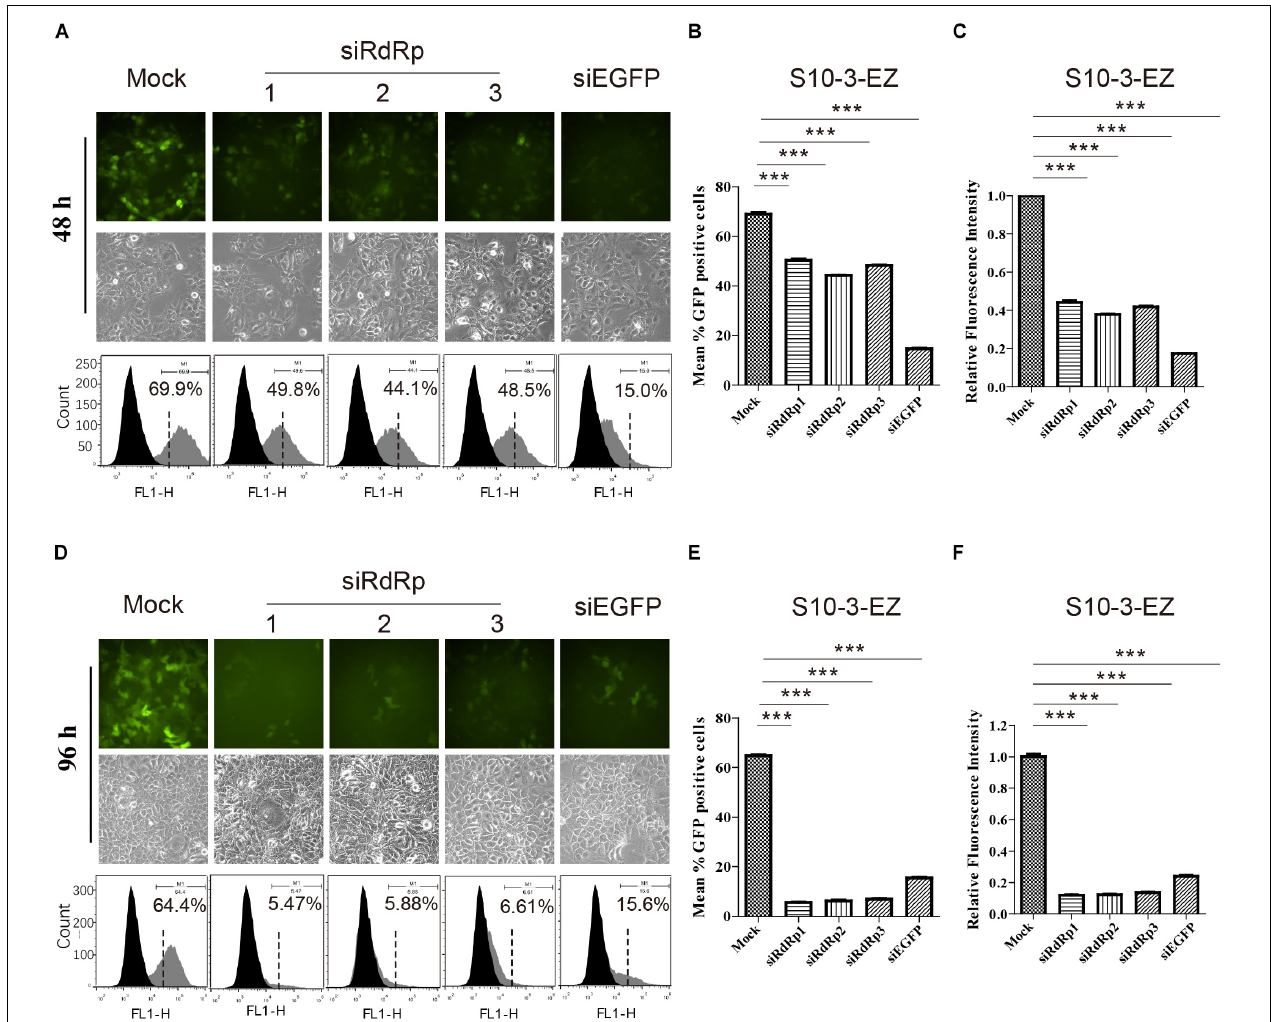
FIGURE 5 | The effects of siRNA interference on persistent HEV replicon cell line S10-3-EZ. (A,D) S10-3-EZ cells were observed by fluorescence microscopy, and GFP-positive cells were counted by FACS 48 h or 96 h after siRNA treatment. (B,E) The number of GFP-positive cells as determined by FACS is shown as a percentage of total counted cells (hpt: hours post-transfection). (C,F) Quantitative FACS analysis confirming siRNA inhibition of GFP expression by RFI. GFP expression in cells treated with siRNA is shown as a relative percentage of the mock-treated control. Error bars indicate standard deviation; * P < 0.05; ** P < 0.01; and *** P <